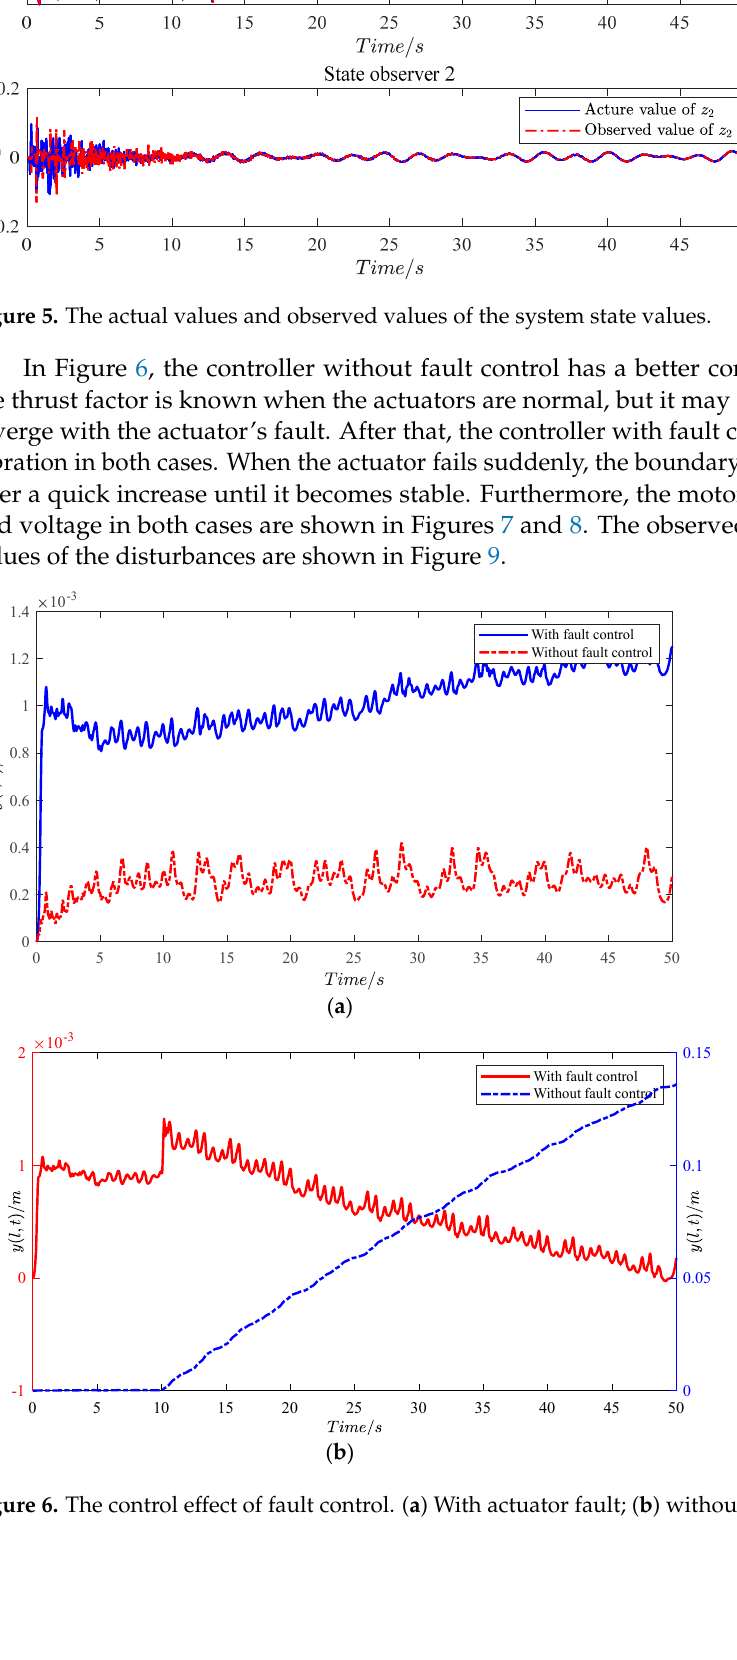
Figure 4. Absolute value of vibration at midpoint of the umbilical cable with different controllers.